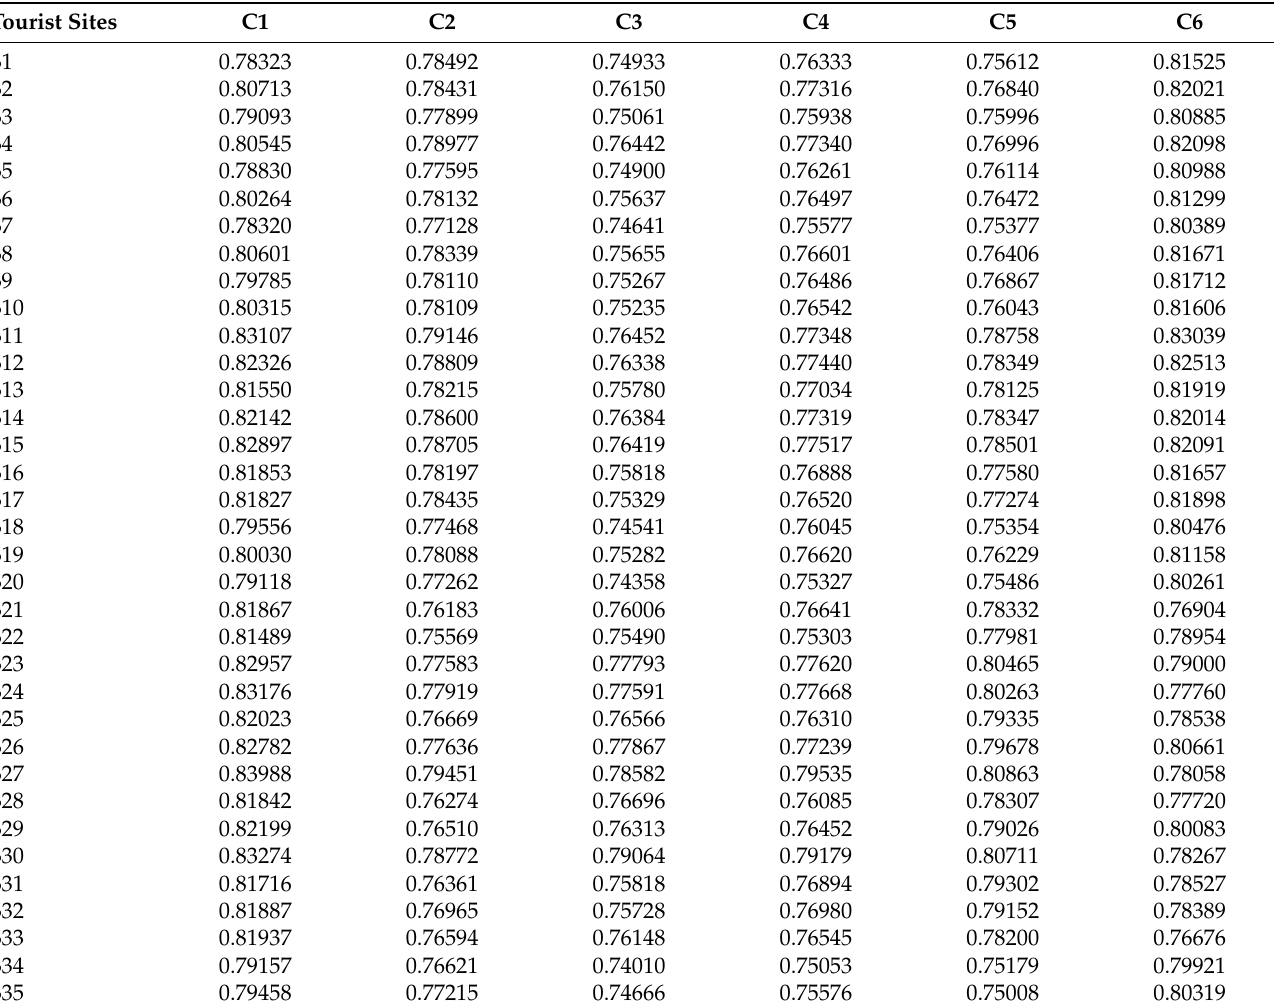
Table 7. The equivalent crisp dataset for the evaluation of tourist